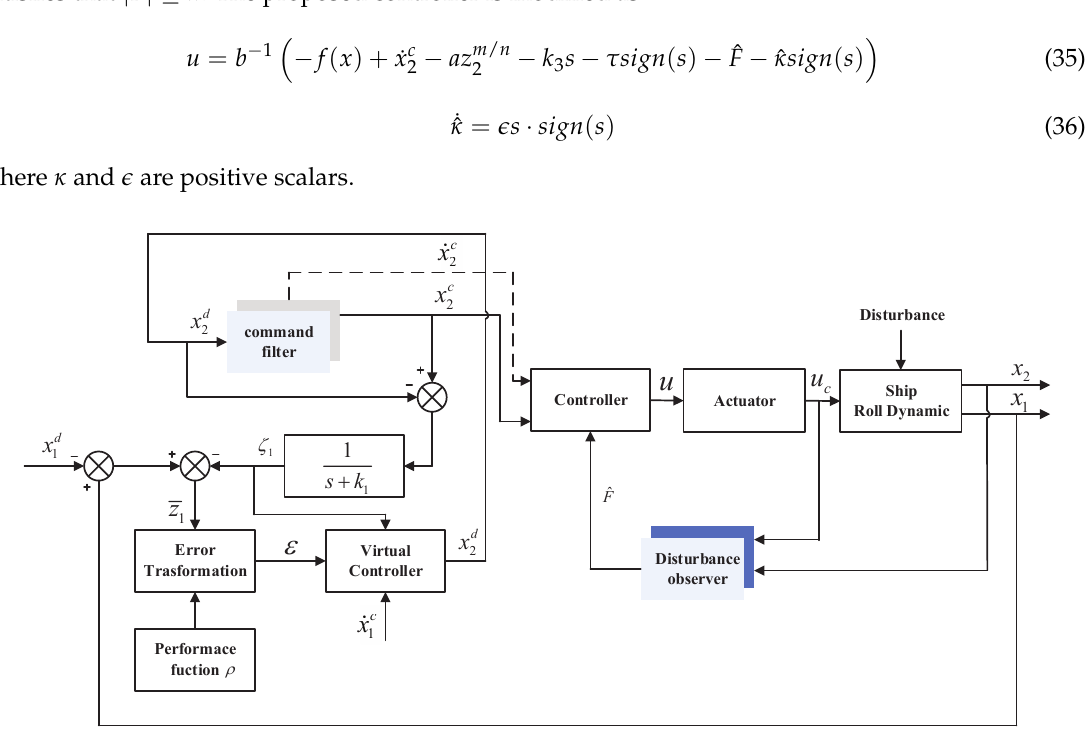
Figure 2. The structure of the proposed method in this